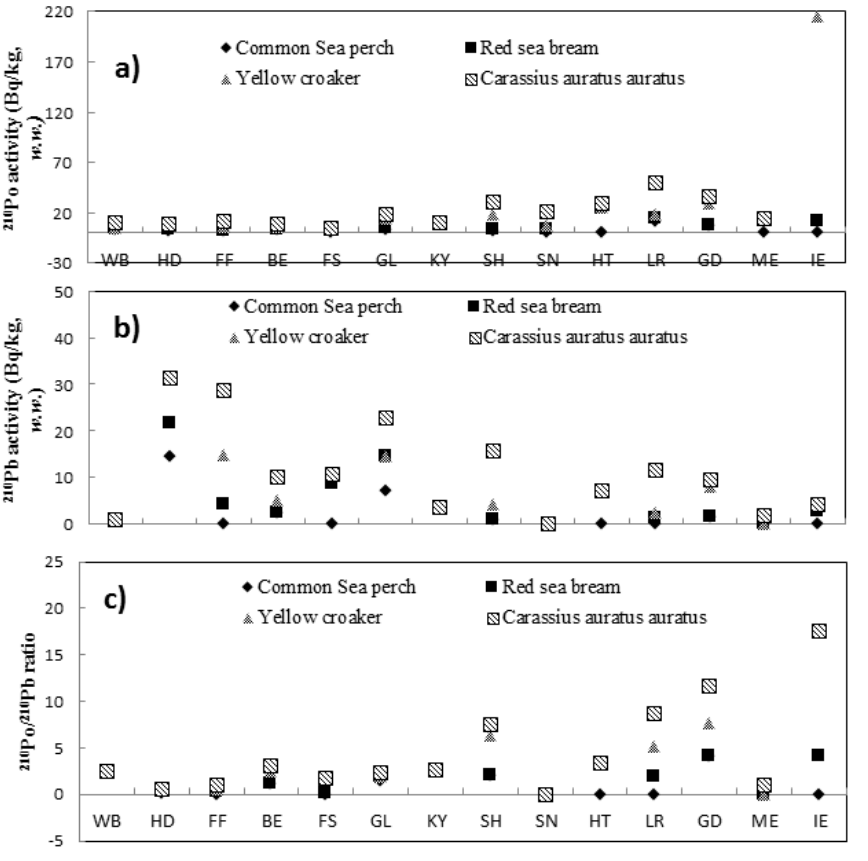
Figure 2. Distributions of the 210 Po and 210 Pb activity concentrations in selected organs of different species. ( a ) is for 210 Po activity concentration; ( b ) is for 210 Pb activity concentration; ( c ) is for 210 Po/ 210 Pb ratio). Note: WB = whole body, HD = head, FF = fish fin, BE = bone, FS = fish scale, GL = gill, KY = kidney, SH = stomach, SN = spleen, HT = heart, LR = liver, GD = gonad, ME = muscle, IE = intestine.